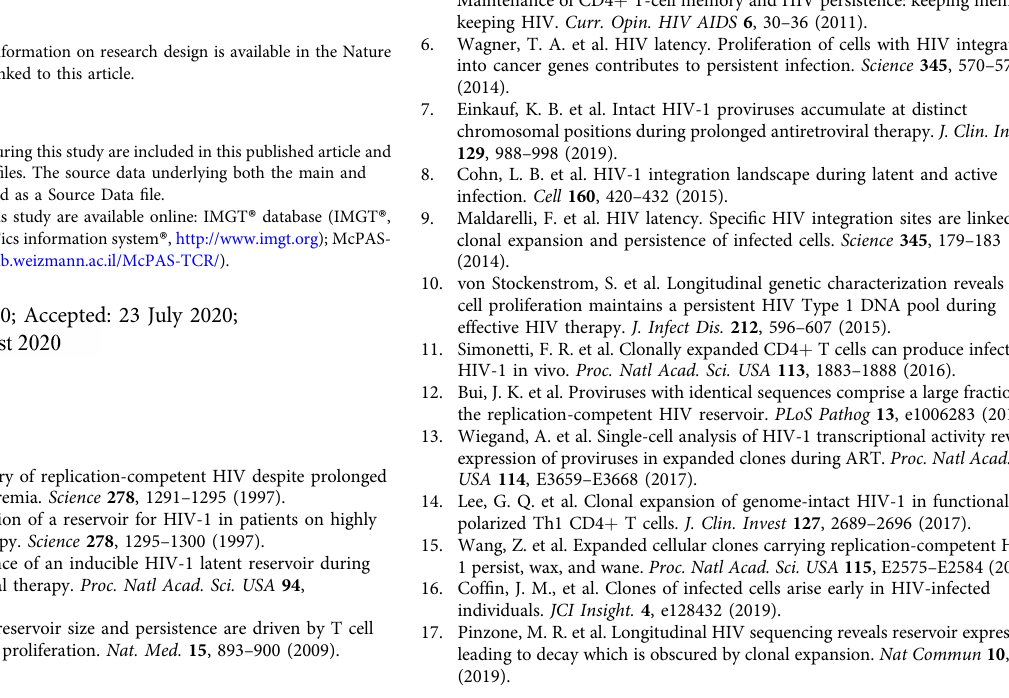
the international ImMunoGeneTics information system ® , http://www.imgt.org); McPAS- TCR database (http://friedmanlab.weizmann.ac.il/McPAS-TCR/).